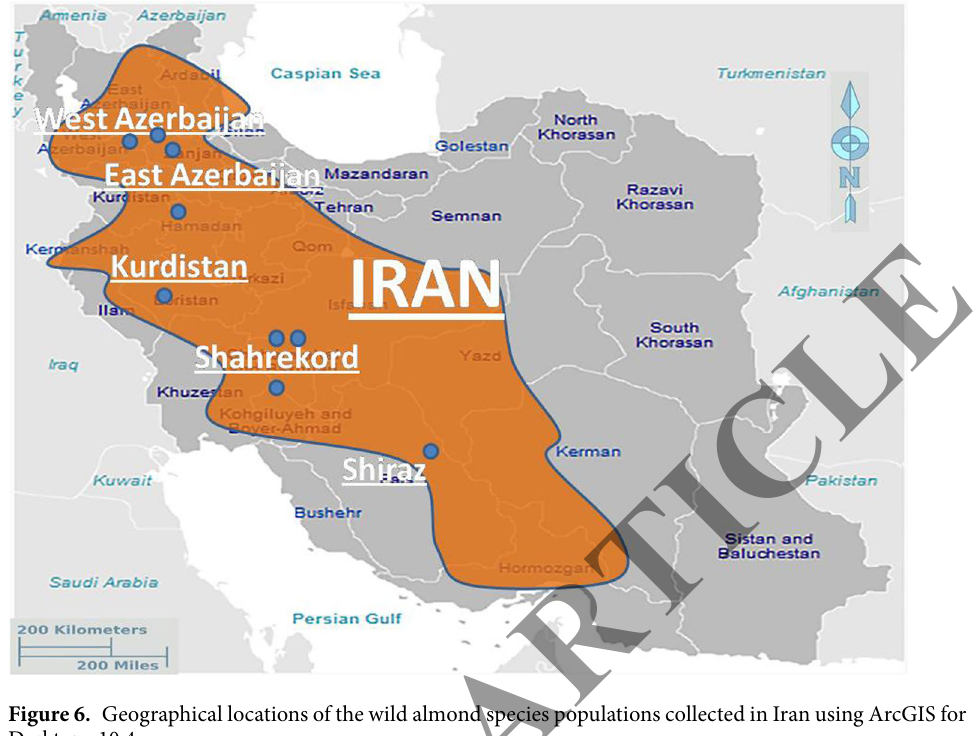
Figure 6. Geographical locations of the wild almond species populations collected in Iran using ArcGIS for Desktop